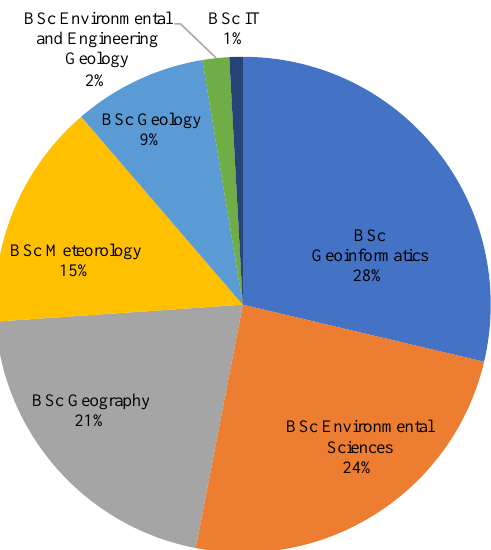
Figure 2. Degree programmes of participants Figure 1. Words selected to describe a mapathon Opinion on mapathons and OSM data